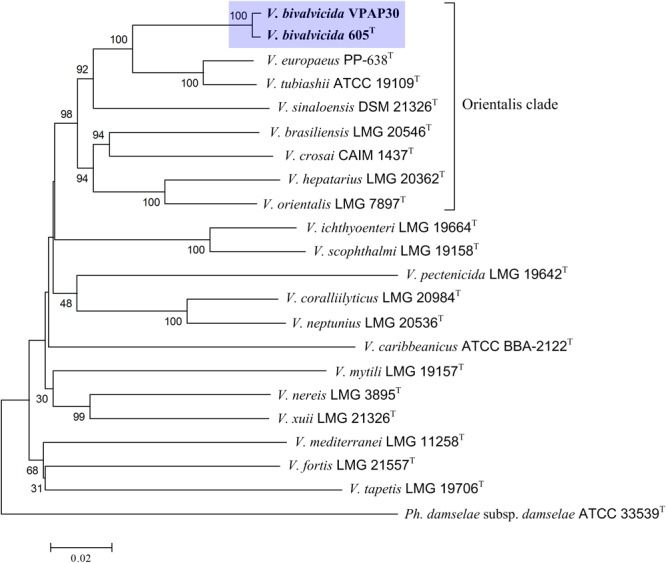
Phylogenetic tree based on concatenated sequences of the housekeeping genes ftsZ, gapA, gyrB, mreB, pyrH, recA, rpoA, and topA obtained by the neighbor-joining method. Horizontal branch lengths are proportional to evolutionary divergences. Bootstrap from 1,000 replicates appears next to the corresponding branch. Photobacterium damselae was used as an outgroup.